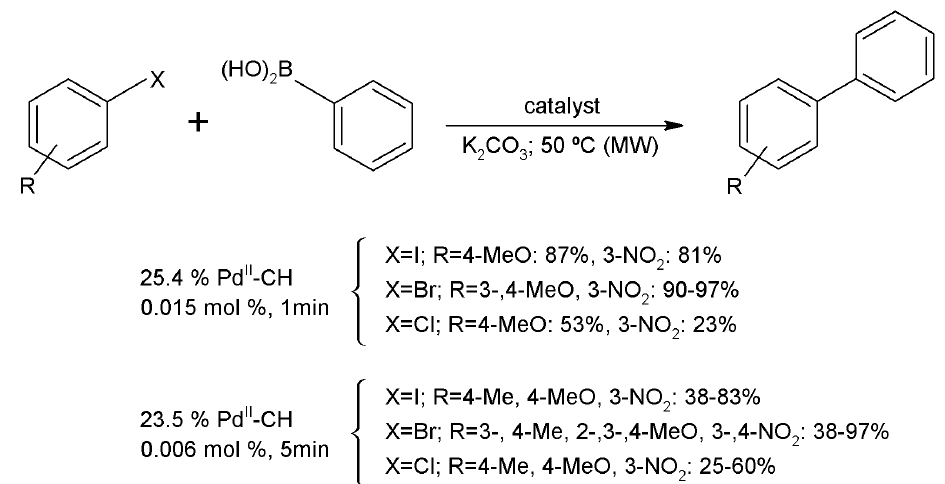
Figure 16. Suzuki couplings using catalysts modified with 6-carboxymethylchitosan.